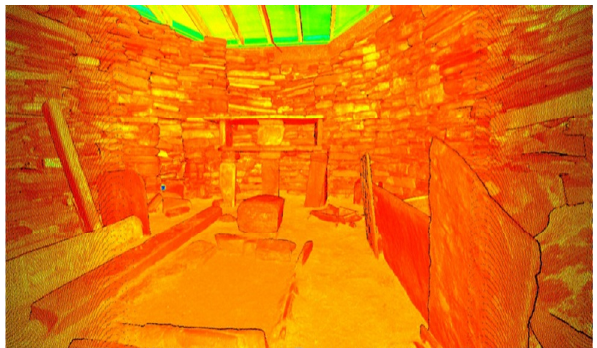
Figure 6. Point cloud of House 7 interior at Skara Brae, coloured by intensity values © CDDV